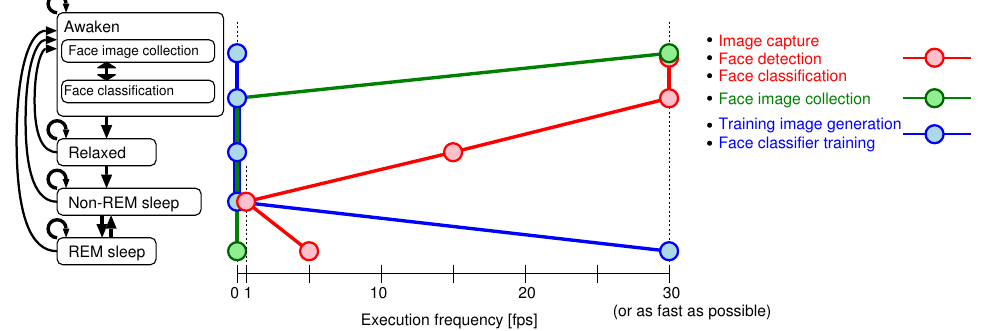
Figure 8. Execution frequency of each process.